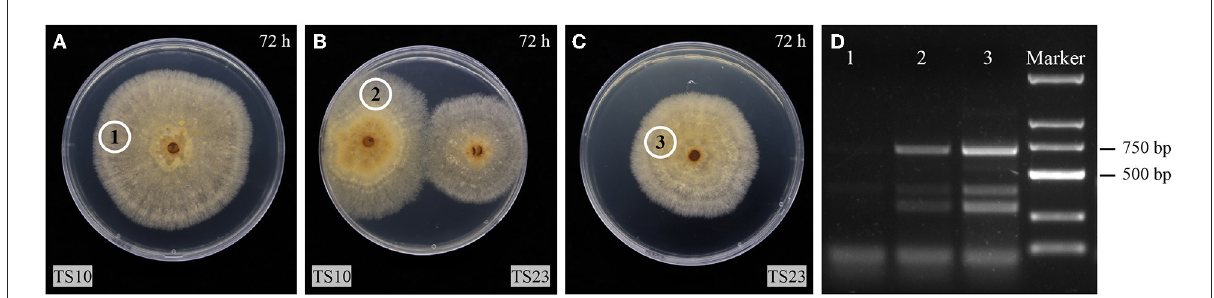
FIGURE4 Horizontal transmission assay of RsPV433. (A–C) TS10 is a strain which is not infected by RsPV433, TS23 is a strain that is infected by RsPV433. All fungal were grow on PDA at 25 ◦ C in dark. The photos were taken at 72h when the mycelial of TS10 and TS23 get in contact with each other. The cycled 1, 2, 3 implies the place where we take the mycelial plugs for RT-PCR detection. (D) RT-PCR detection of RsPV433, use the primer sets Rs4bF2/Rs4bR2 for the detection of RsPV433 dsRNA2. Lane 1, 2, 3 represent the sample we marked with cycle in A–C , samples were taken at 96h when TS10 and TS23 have contacted for 24h.